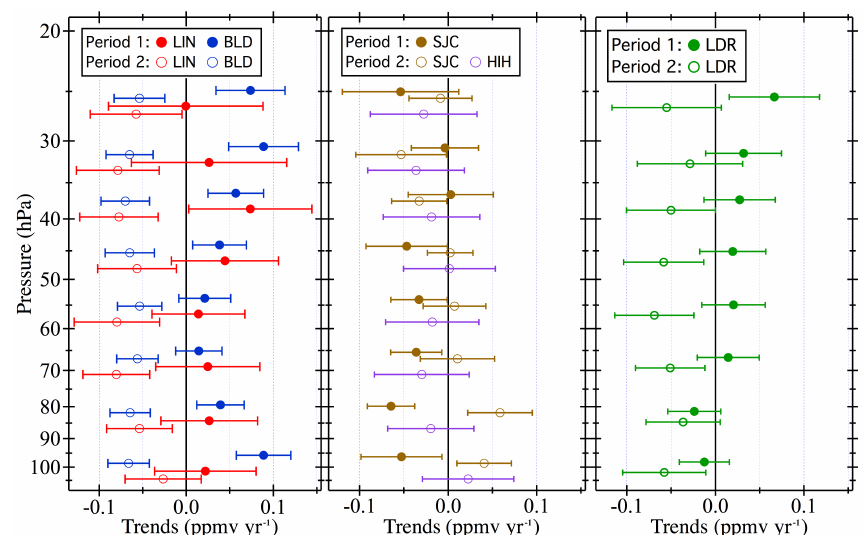
Figure 3. Trends in FP–MLS differences for the pre- and post-changepoint periods at eight stratospheric pressure levels (100–26hPa) over the five FP sounding sites. Markers for each pressure level are slightly offset in pressure for clarity. Horizontal error bars depict the 95% confidence intervals of the trends. Only period 2 trends are shown for Hilo because the shorter records show no indications of statistically significant changepoints. Table 4. Changepoint dates and their confidence levels, MLS version 4.2. Lindenberg Boulder San José Lauder Pressure Changepoint